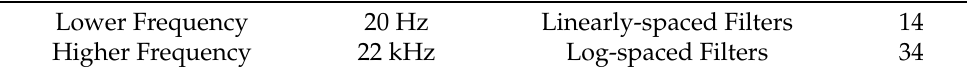
Table 6. Mel Frequency Cepstrum Coefficients (MFCC) bank filter